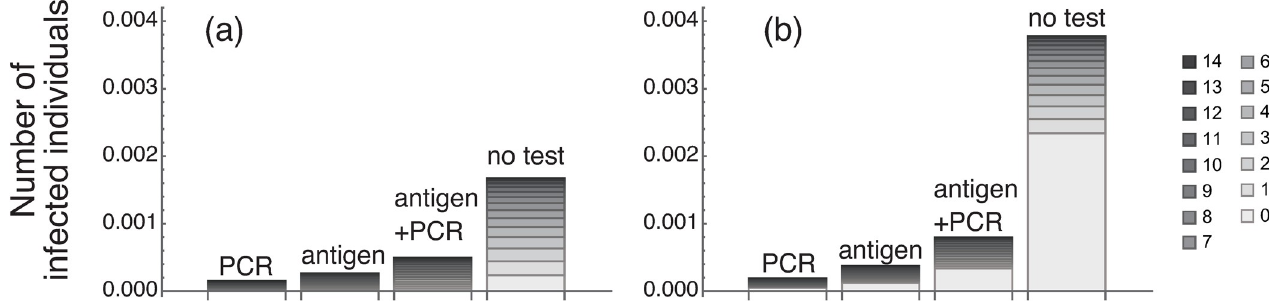
Fig 5. The contribution of the day on which the infected individual appeared. (a) Results with parameters in Table 2. (b) Results when the probability that an individual was infected at arriving ( p p ) was 10 times higher (other parameters were the same). Test error rates were assumed to be 0%.